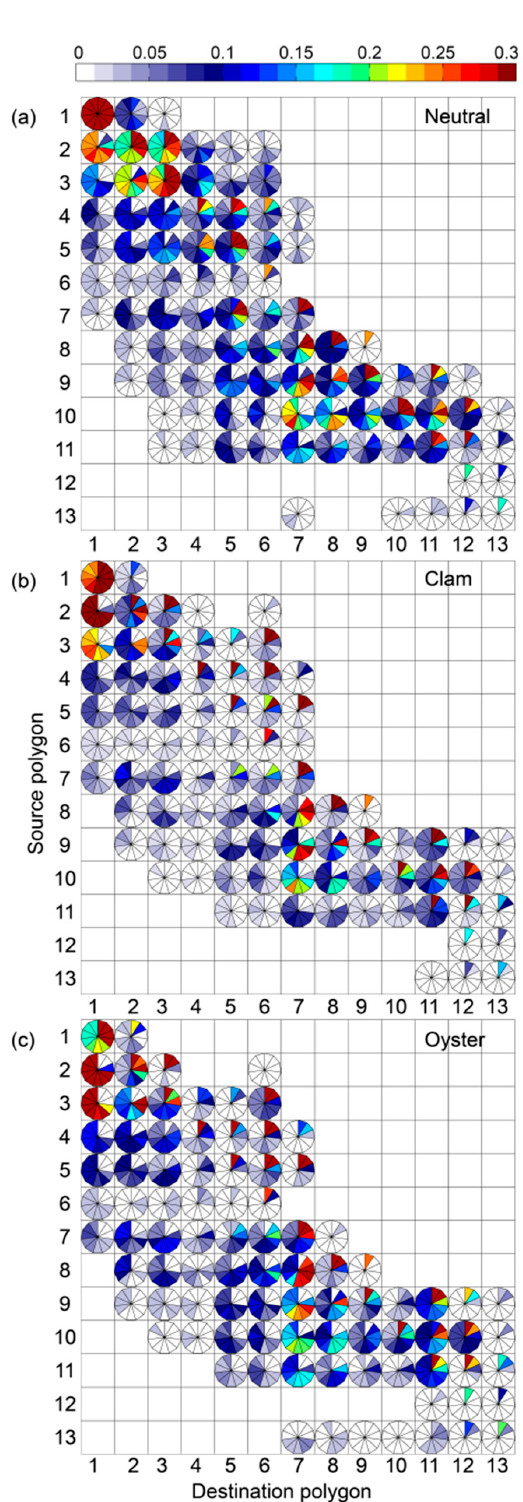
Figure 4. Connectivity among release polygons ( y -axis) and destination polygons ( x -axis). Color of each 2-day slice shows the proportion (fraction) of particles that move from the source polygon to the destination polygon. The clocks on the diagonal correspond to local retention. All releases use 1000 particles from each release point (n = 13,000 total particles per simulation), panels show connectivity for ( a ) neutral, ( b ) clam, and ( c ) oyster behavior scenarios. Source–destination combinations without a clock (grey box) denote combinations for which no connectivity